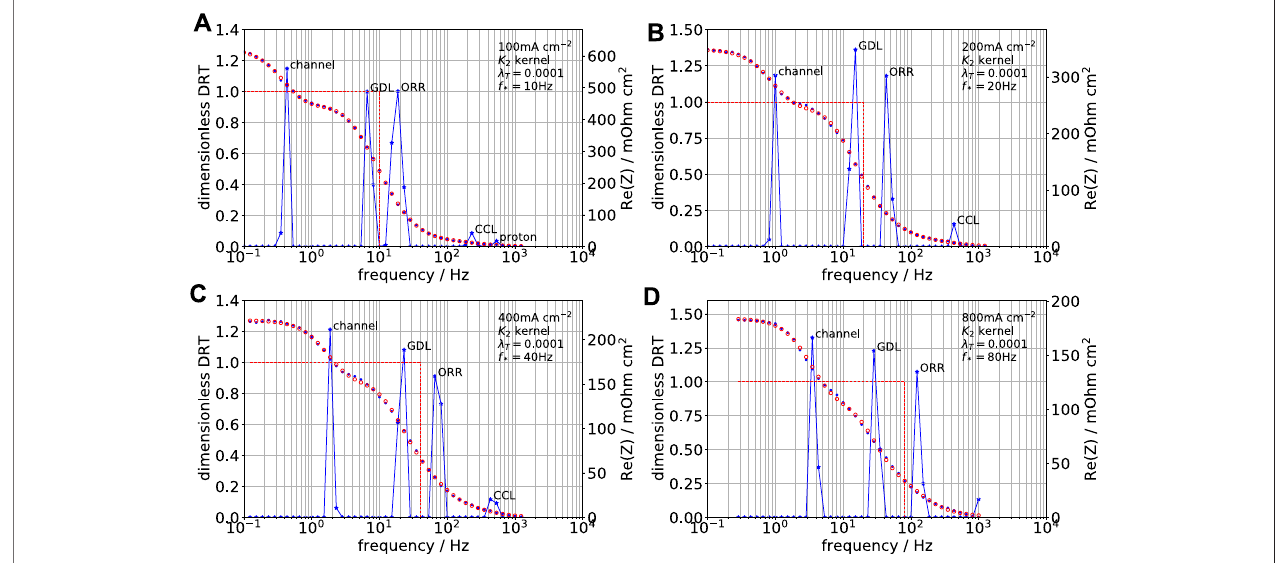
FIGURE 7 | DRT (solid line, left axis) calculated with the K 2 kernel using real part of the experimental PEMFC impedance (blue dots, right axis) for the current densities (A) 100, (B) 200, (C) 400, and (D) 800 mA cm − 2 . Red open circles — Re ( Z ) reconstructed from the calculated DRT. Dashed line shows the plot of α , Eq. 14 , switching the K 2 kernel from TL – to RC – one at the frequency marked by vertical